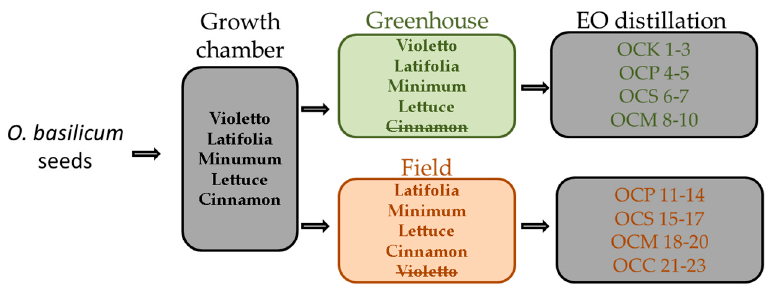
Figure 5. Diagrammatic presentation of the cultivation of basil seeds belonging to five varieties in field and greenhouse, along with the relevant obtained essential oils (EOs).